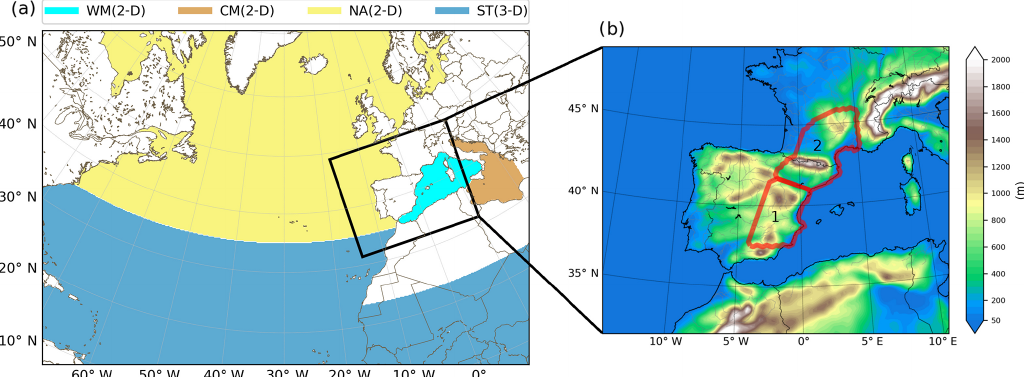
Figure 2. (a) Simulation domain and moisture sources considered: western Mediterranean (light blue), central Mediterranean (brown) and North Atlantic (yellow) 2-D sources and tropical and subtropical 3-D source (dark blue). (b) The domain for precipitation analysis with topography (in metres) indicated using colour. The areas highlighted in red are the most affected by the October (1) and the November (2)